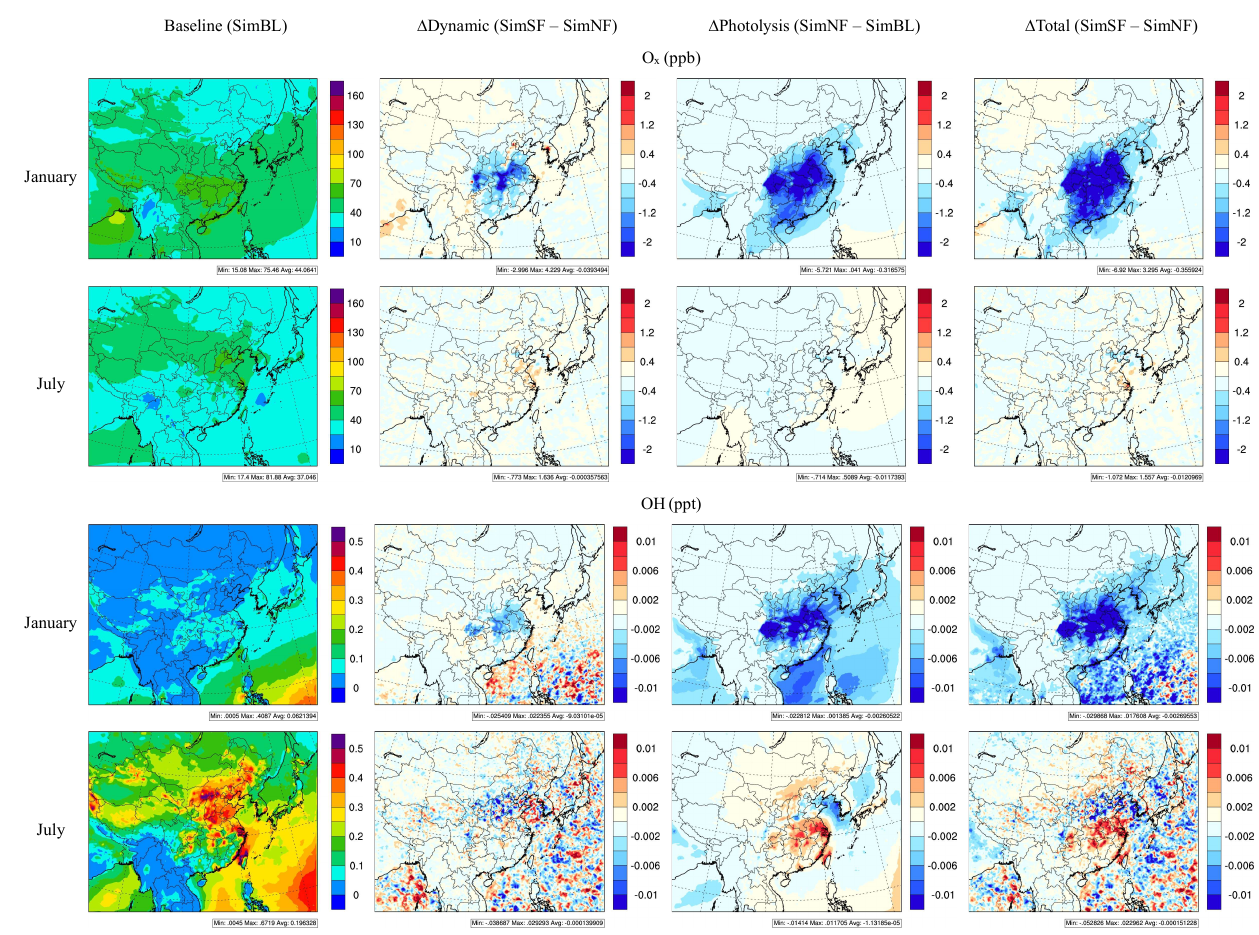
Figure 7. Impacts of ADEs on surface O x and OH (monthly average of noon time 11:00–13:00 local